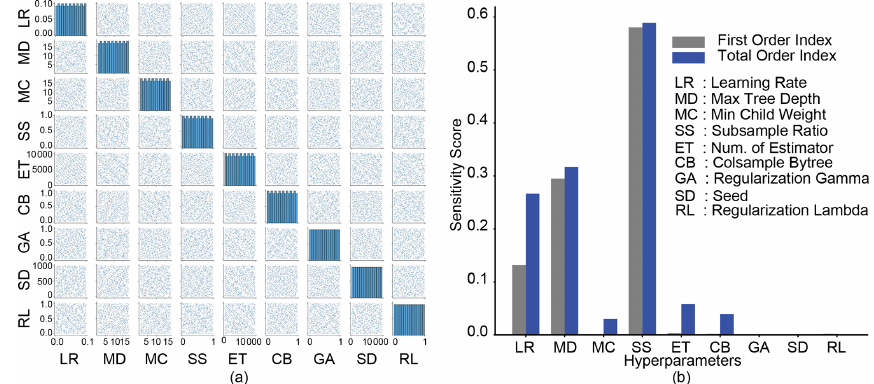
Figure 3. (a) Samples of nine hyperparameters associated with the extreme gradient boosting (XGBoost) algorithm for the global sensitivity analysis. The histogram plots on the diagonal describe the actual sample distribution for a given hyperparameter. Each bar in the histogram plots measures the sample size in the corresponding interval. (b) Comparison of the sensitivity scores of the nine hyperparameters for both first (gray) and total (blue) order Sobol indices.